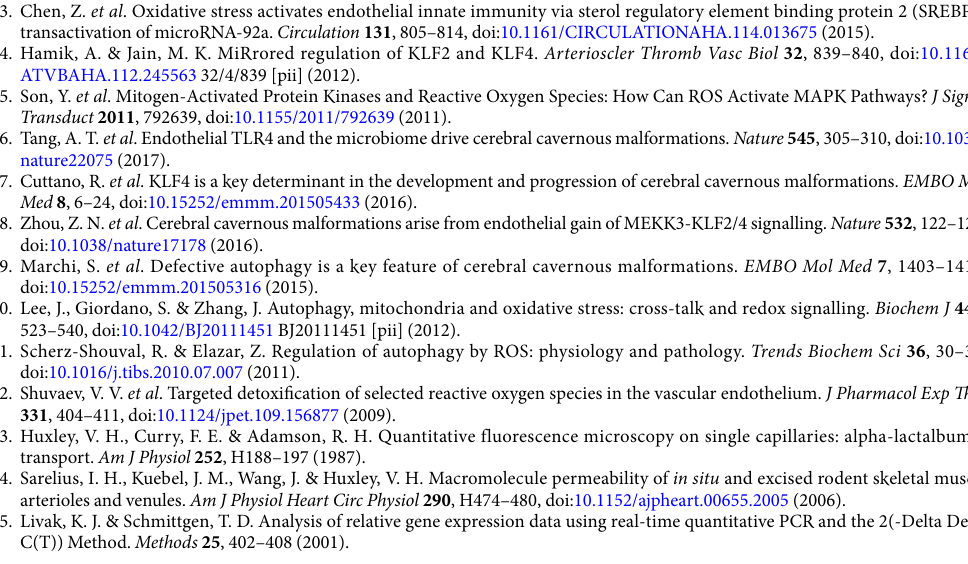
Figure 3. S.F.R., E.T., L.G., A.M., and P.V.D. prepared Figure 4. A.M., J.K. and P.V.D. prepared Figure 5. All authors contributed intellectually and reviewed the